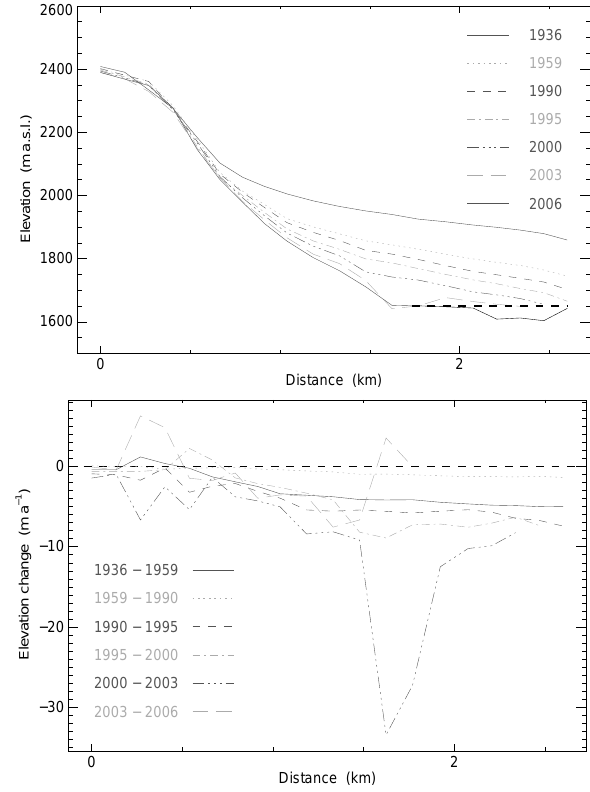
Fig. 6. Longitudinal profiles (above) and rate of elevation changes (below) of the lower part of Triftgletscher since 1936.